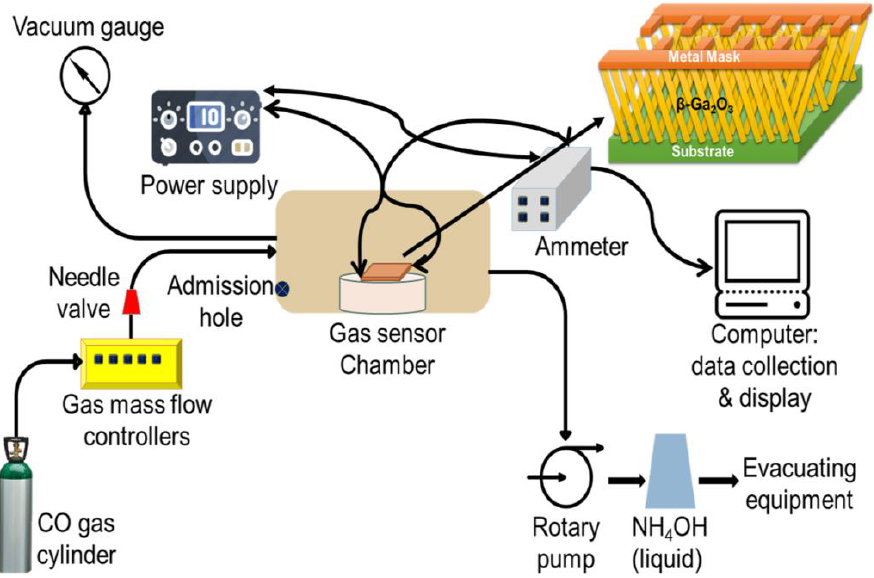
Figure 2. An architecture diagram of a CO gas sensing measuring unit. Reprinted with permission from Ref. [31].